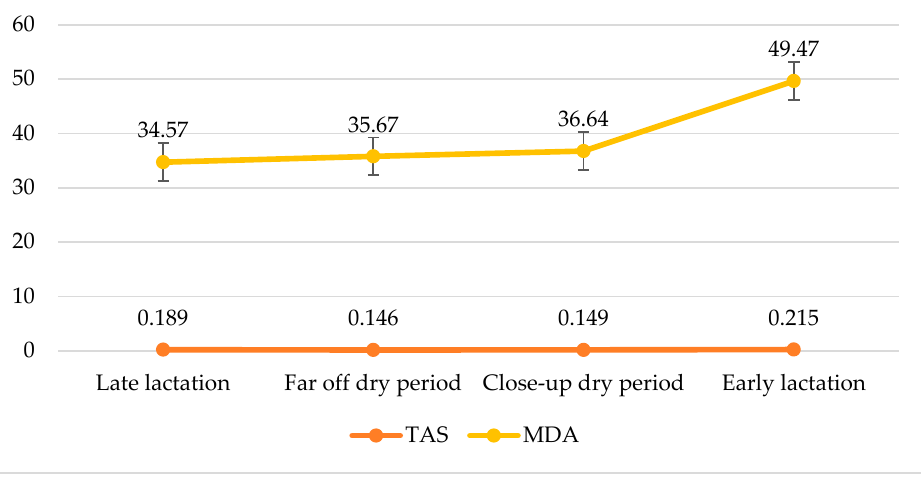
Figure 3. TAS (mmol/L) and MDA (µM/L) values in serum of cows in different periods.